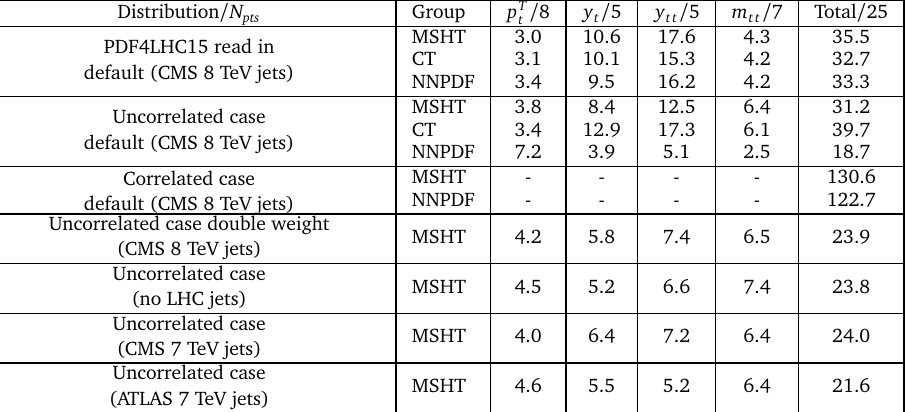
Table 3: χ 2 for the ATLAS 8 TeV t ¯ t lepton + jets distributions when added to the reduced fit, before fitting with PDF4LHC15 PDFs read in, after fitting but including all 4 distributions in an “uncorrelated” manner and after fitting maintaining all statistical and systematic correlations between the distributions. The effect of double weighting small datasets and of the inclusion of different jet datasets in the reduced fit is also shown, with the LHC jet dataset included in